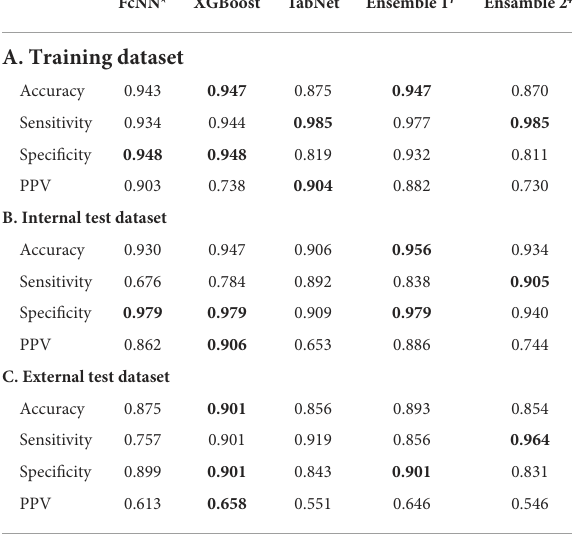
TABLE 2 Performances of artificial intelligence